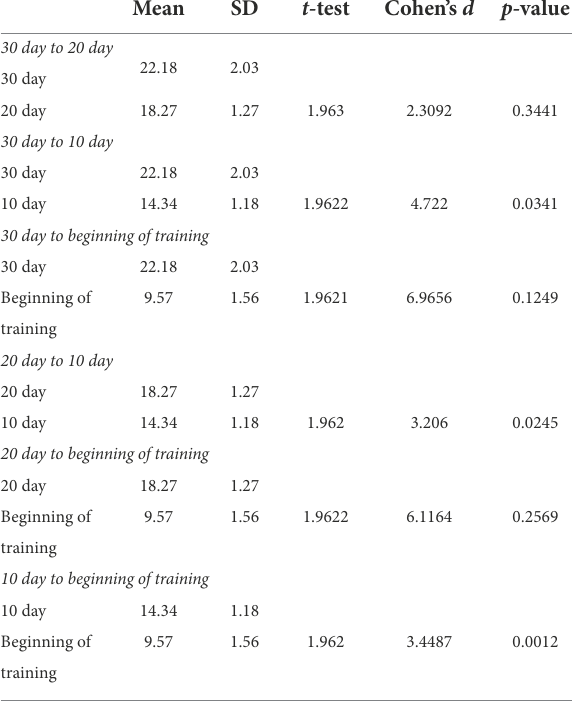
Table 2 p -values for paired Student’s t -test comparing the K10 results. Mean SD t -test Cohen’s